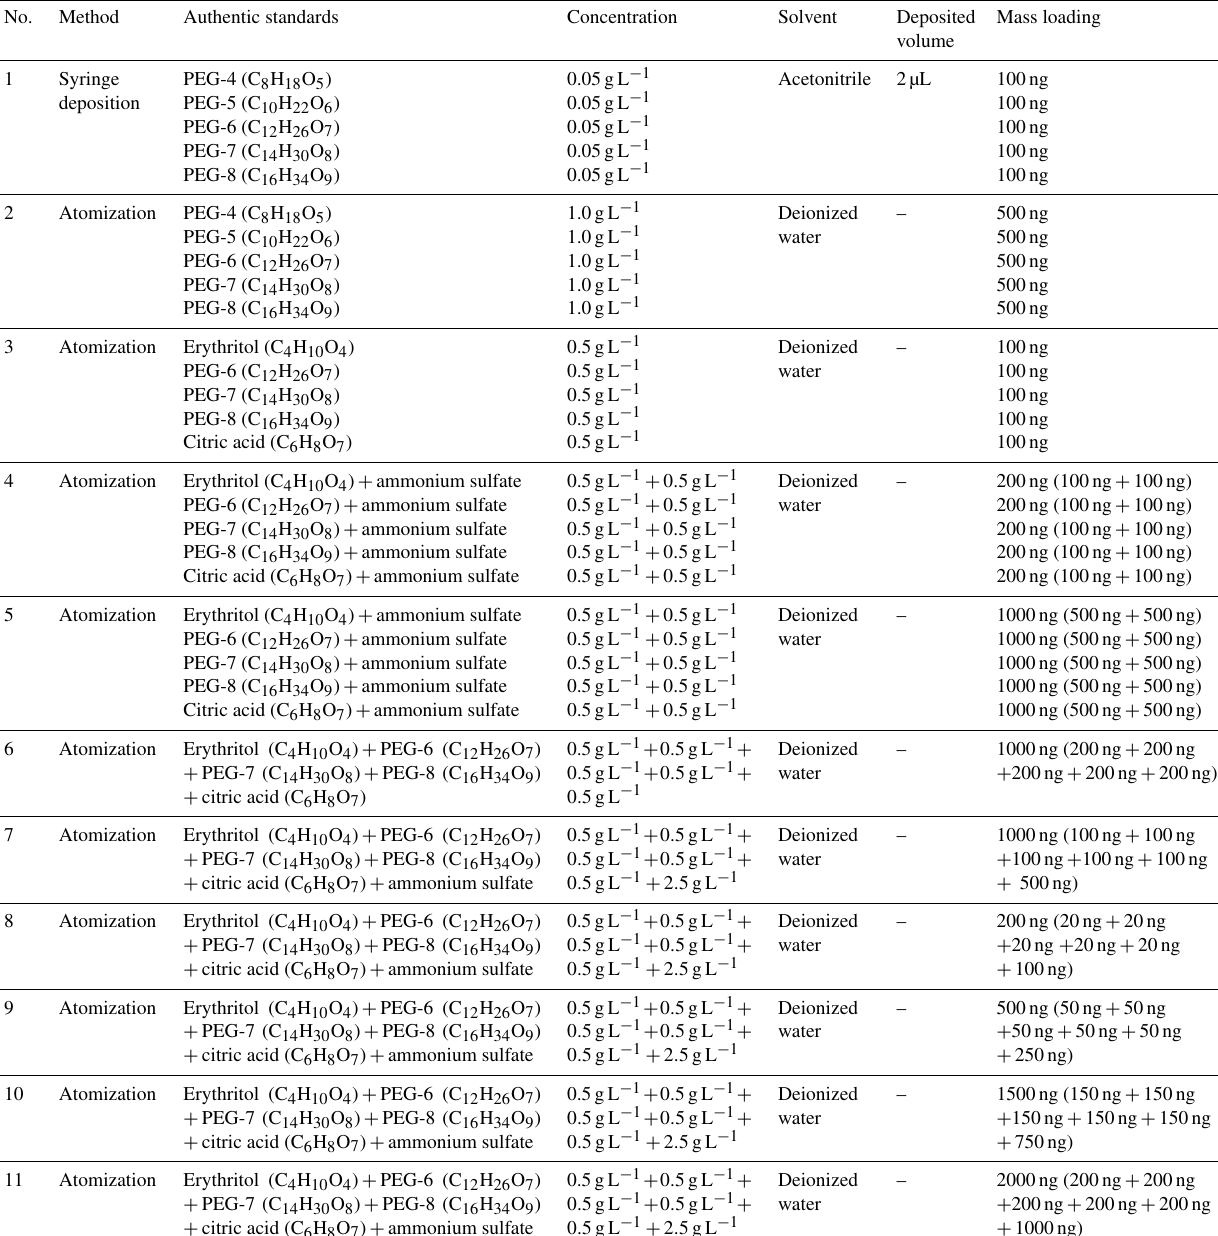
Table 1. Conditions of 11 sets of calibration experiments.